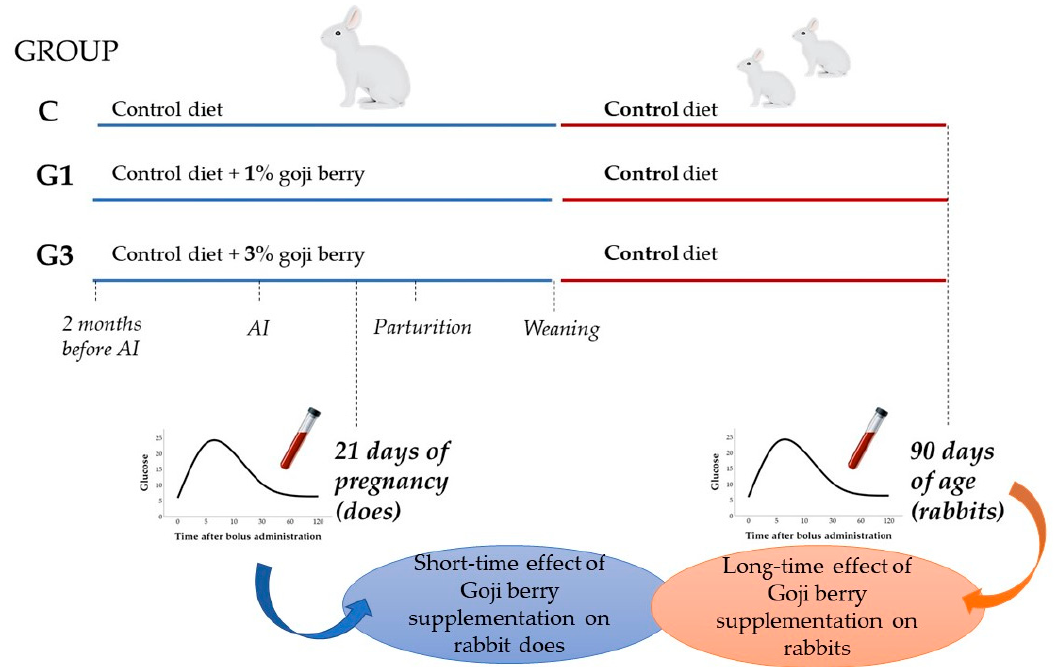
Figure 1. Graphic representation of the experimental protocol. From two months before artificial insemination (AI) until weaning of the litters, rabbit does of groups C, G1, and G3 were fed a standard diet (C group), standard diet supplemented with 1% Goji berry (G1 group), and 3% Goji berry (G3 group), respectively (n = 75). After weaning, rabbits in all groups received the standard diet. Simple and intravenous glucose tolerance test-derived indices were estimated at 21 days of pregnancy on rabbit does to evaluate the short-time effect during pregnancy, and at 90 days of age on rabbits to evaluate the long-term effects on the offspring. The blue and red lines indicate the maternal and offspring feeding, respectively.